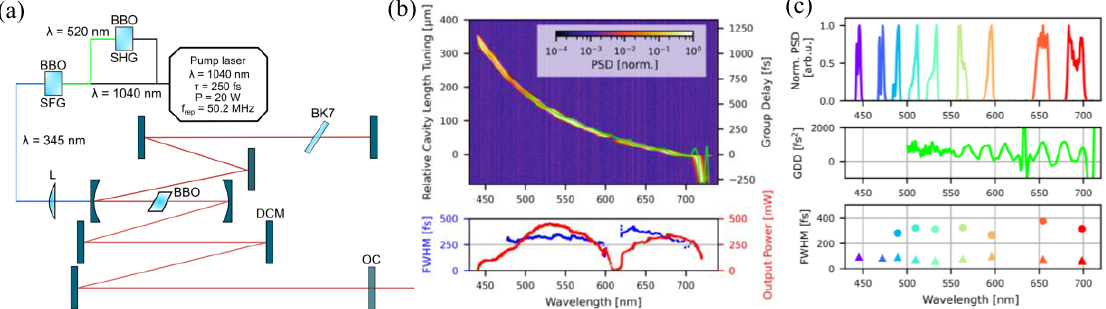
Fig. 1 (a) Setup of the VIS-NOPO: BBO SHG ( Θ = 23.2 ° , L = 1.5 mm ), BBO SFG ( Θ = 32.5 ° , L = 1 mm ) , L: plane- convex lens (f = 200 mm), BBO OPO ( Θ = 39 ° , L = 2 mm ), BK7-substrate ( L = 12 mm ), OC: output coupler ( R = 86 % ); (b) Upper graph: Recorded signal spectra of the VIS-NOPO while varying the cavity length at 3 W of pump power. Lower graph: corresponding output power (red scale on the left) and pulse duration (blue scale on the right) for center wavelengths of spectra in the upper graph. (c) Upper graph: arbitraly selected signal spectra of the VIS- NOPO. Middle graph: calculated net group delay dispersion of the VIS-NOPO cavity. Lower graph: measured pulse duration for selected signal spectra (circles) and calculated transform-limited pulse duration (triangles). The tunability range of the VIS-NOPO spans from 440 – 720 nm with a maximum output power of 450 mW at 530 nm and pulse durations down to 200 fs at 528 nm, as illustrated in Fig. 1(b). The strong decrease in output power at 613 nm arises from the parasitic SHG phase matching in BBO. In conclusion, our measurements show for the first time that the VIS-NOPO can generate high power femtosecond laser pulses quickly tuneable over nearly the visible spectral